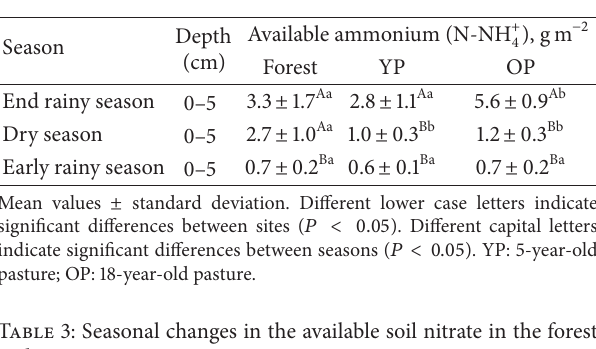
Table 2: Seasonal changes in the available soil ammonium in the forest and pastures.